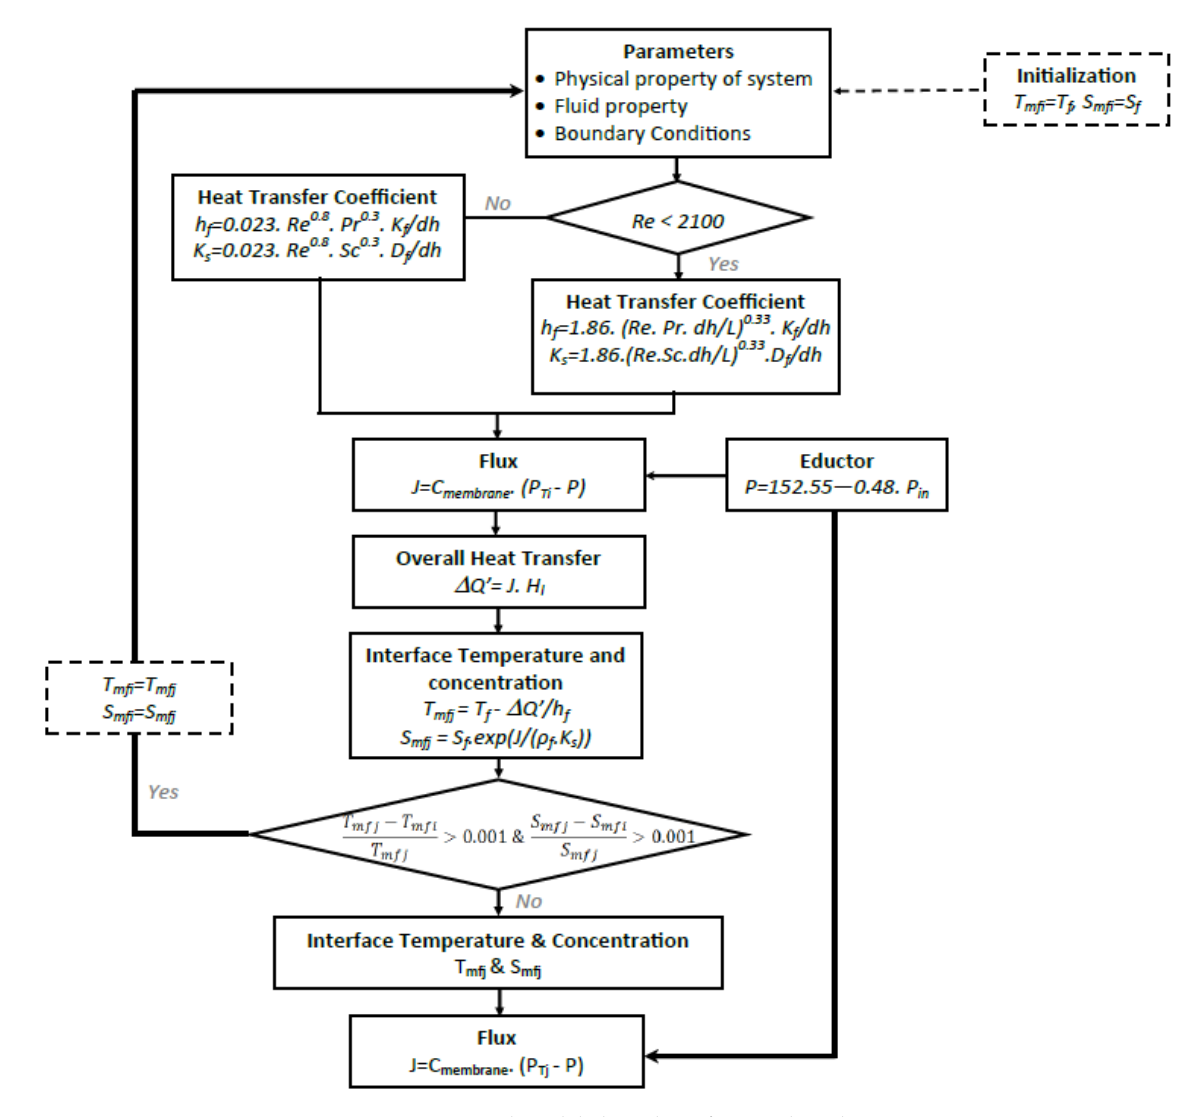
Figure 34. Numerical model algorithm of ejector based VMD.